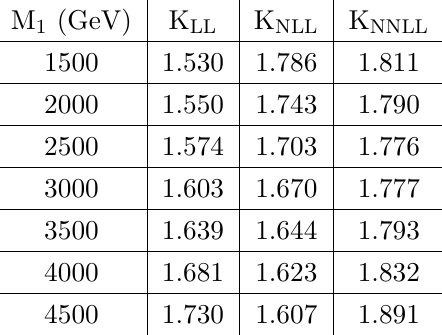
tively. Moreover, these uncertainties are bit larger than the corresponding ones for